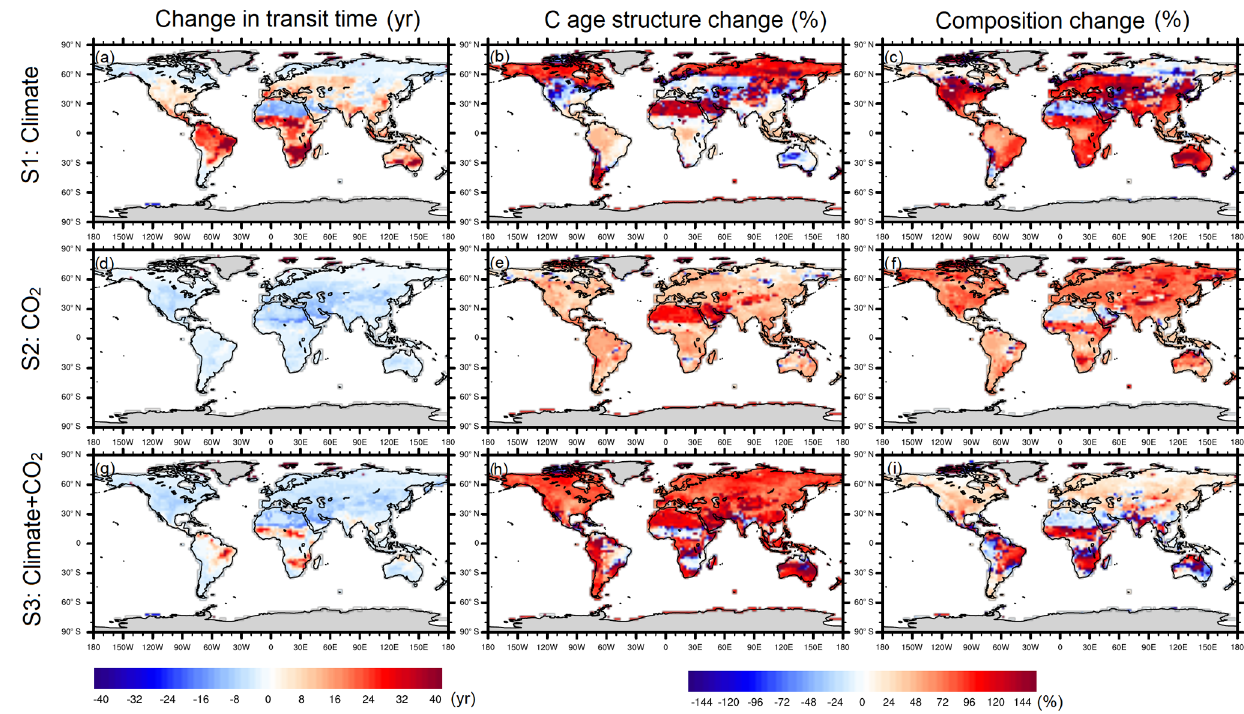
Figure 4. Global map of the change in C transit time in (a) S1: climate warming scenario, (d) S2: rising atmospheric [CO 2 ] scenario, and (g) S3: combined climate warming and rising atmospheric [CO 2 ] scenario. In these three scenarios, contribution from C age structure change and contribution from respired C composition change are also estimated in relation to the change in C transit time (S1: a and c ; S2: e and f ; S3: h and i ). The calculation of the contribution from C age structure change and contribution from respired C contribution change is based on Eq. (6). The positive contribution indicates the C age structure change or composition change leads to C transit time change in the same